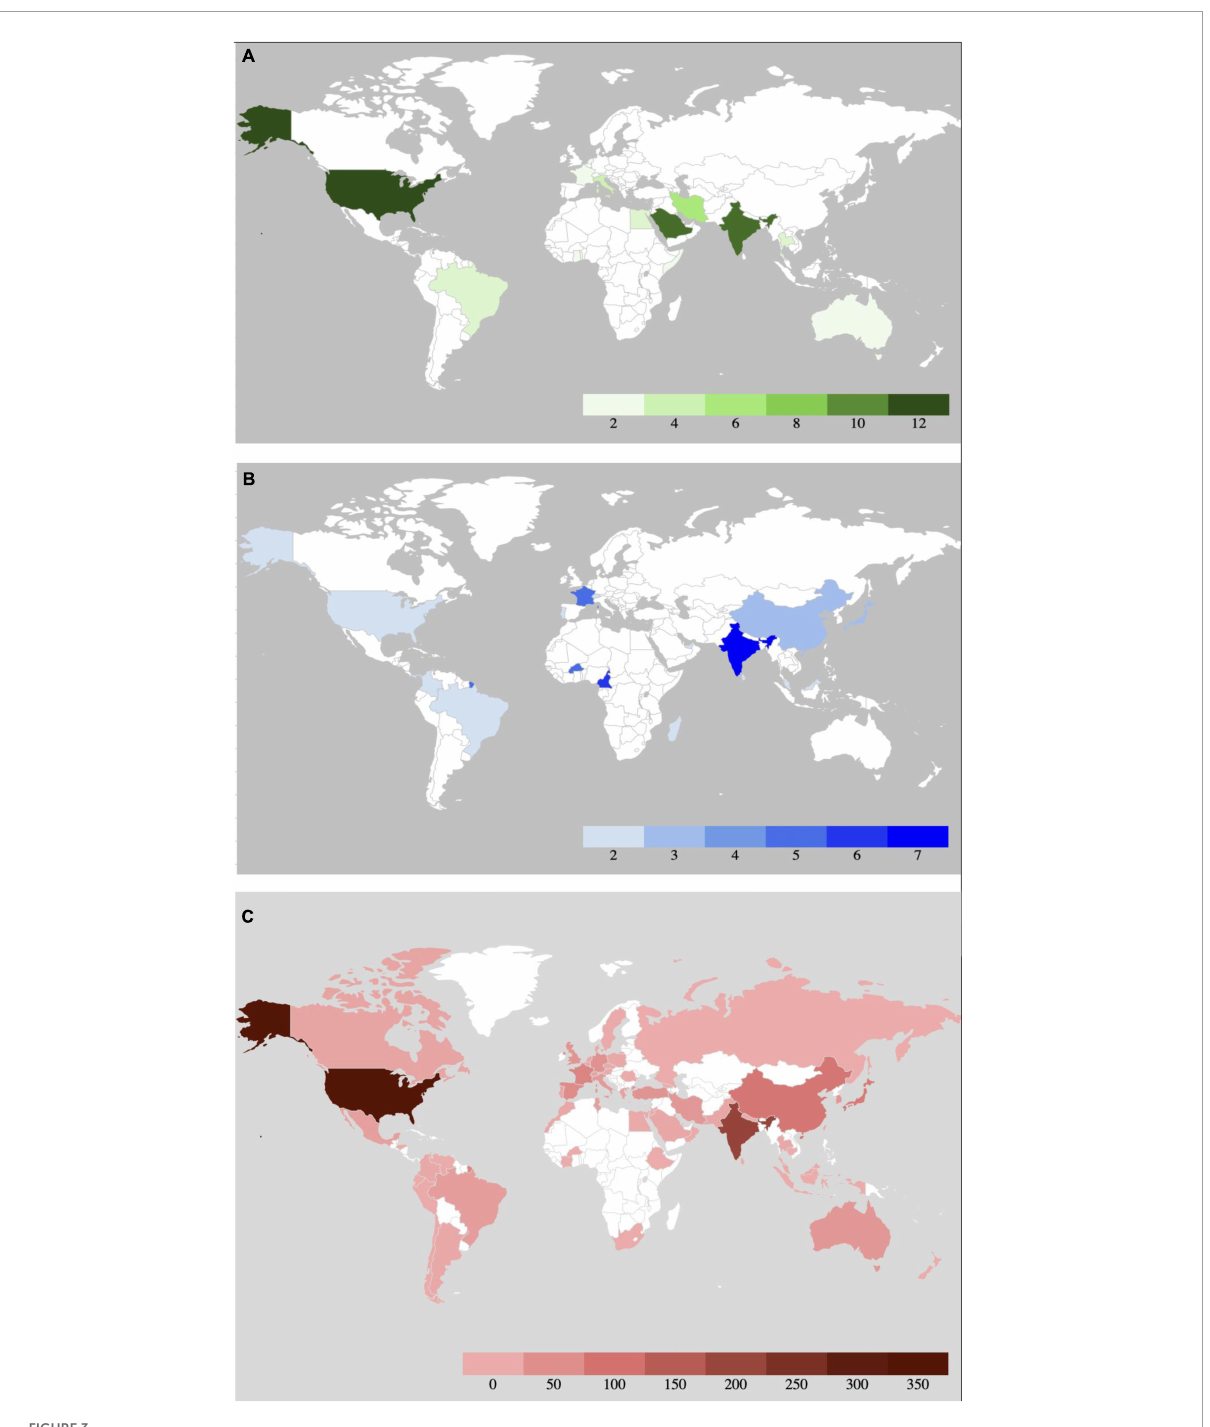
FIGURE3 Global prevalence of infections by Mucorales , Conidiobolus spp. and Basidiobolus spp. based on a systematic review of case reports. (A) A systematic review of case reports with the term basidiobolomycosis and Basidiobolus from 1987 to 8/29/2022 was performed in PubMed. Cases with confirmed Basidiobolus spp. infections that allowed identification of the reporting country were included. Detailed information can be found in supplement A. (B) A systematic review of case reports with the term conidiobolomycosis and Conidiobolus spp. from 1978 to 8/29/2022 was performed in PubMed. Cases with confirmed Conidiobolus spp. infections that allowed identification of the reporting country were included. Detailed information can be found in supplement B. (C) A systematic review of case reports with the term mucormycosis between from 2000 to 8-22-2022 was performed in PubMed. Cases with confirmed Mucorales infections that allowed the identification of the reporting country were included. Detailed information can be found in supplement C. Systematic reviews were performed following the PRISMA 2020 criteria (Page et al.,